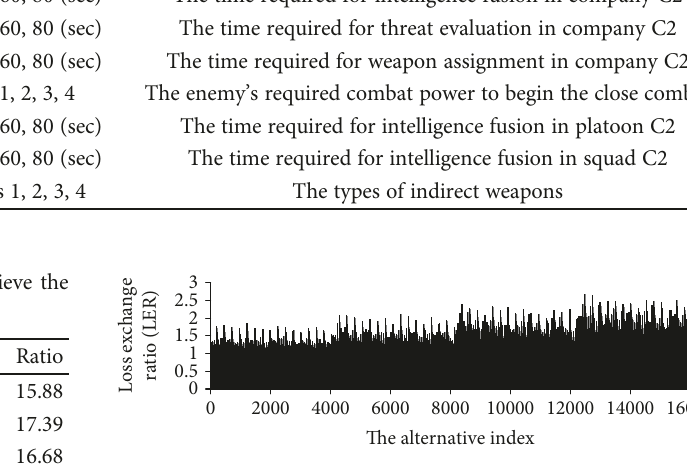
Figure 12: The precise LER for 16,384 designs estimated by 200 replications per design using the integrated simulation model.